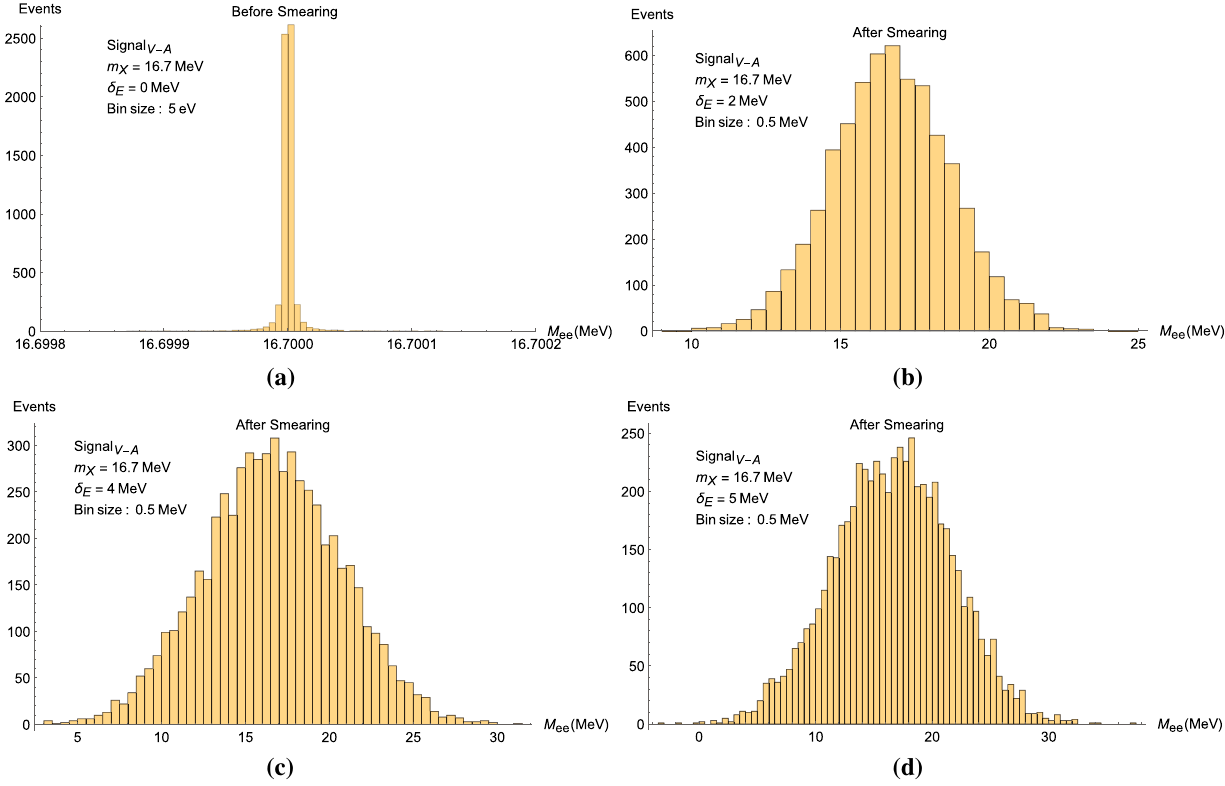
Fig. 5 The X resonance bump of “Signal V − A ” before and after smearing simulated with 6000 X events. The b – d diagrams correspond to the energy resolution of δ E = 2 , 4 , 5 MeV after smearing